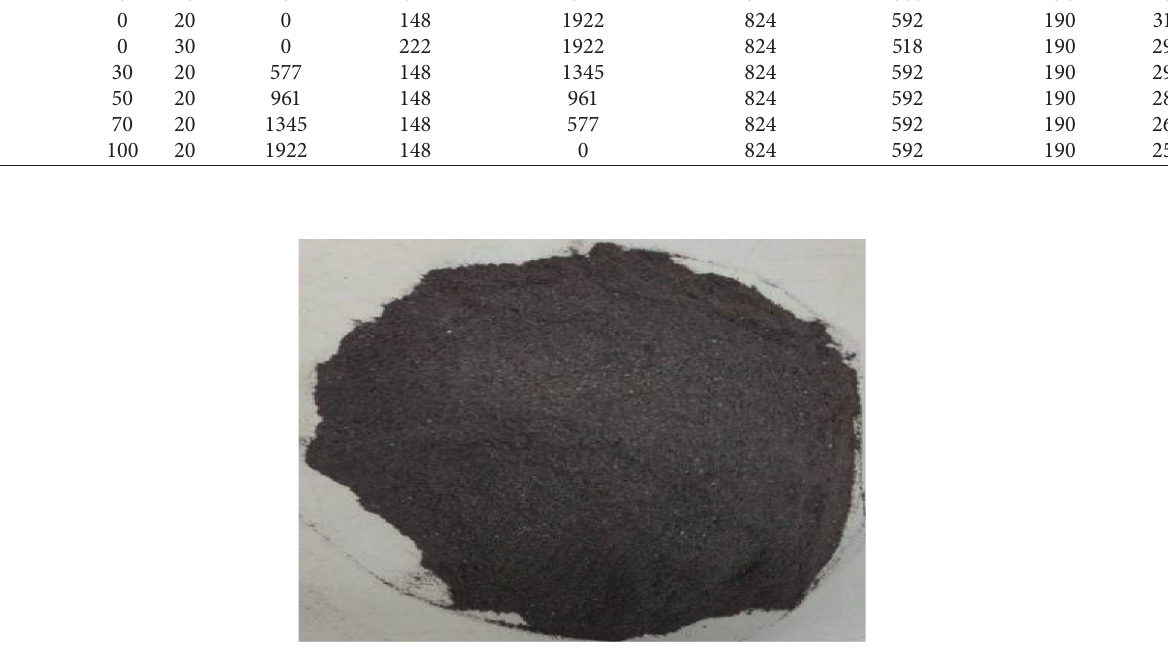
Figure 1: Lithium